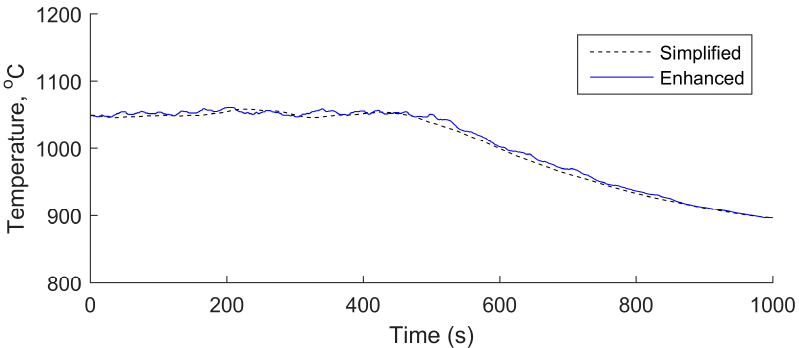
Figure 9. Comparison of the predictions of averaged char layer temperatures from the mechanistic to the ones from the simplified model.